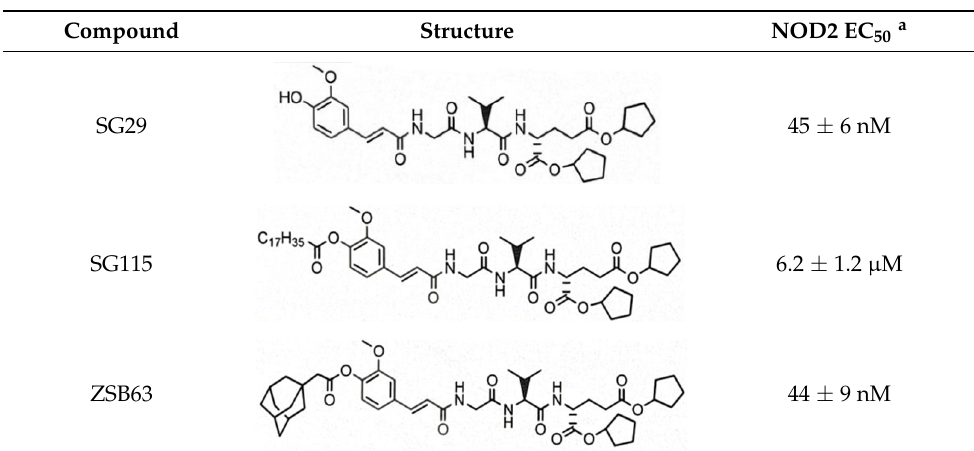
Table 1. NOD2 agonistic activities of lipidated SG29 analogs.